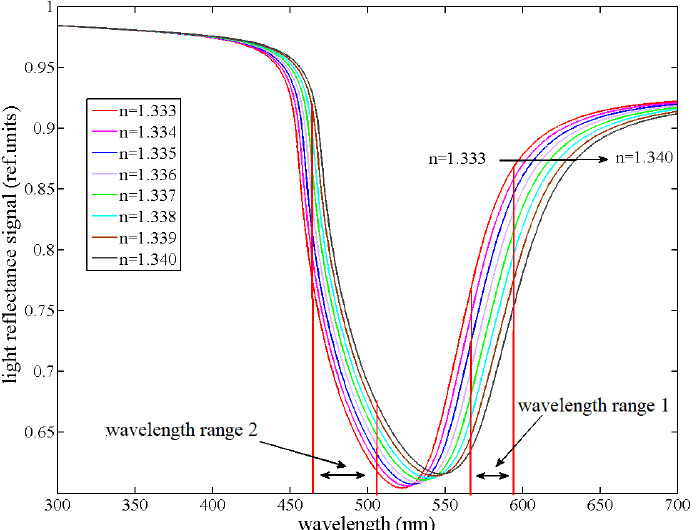
Figure 4. The fiber-optic SPR resonance spectra at different RI (core: 200 µ m, 0.36 NA, sensor length: 10 mm, 50 nm gold film at 300